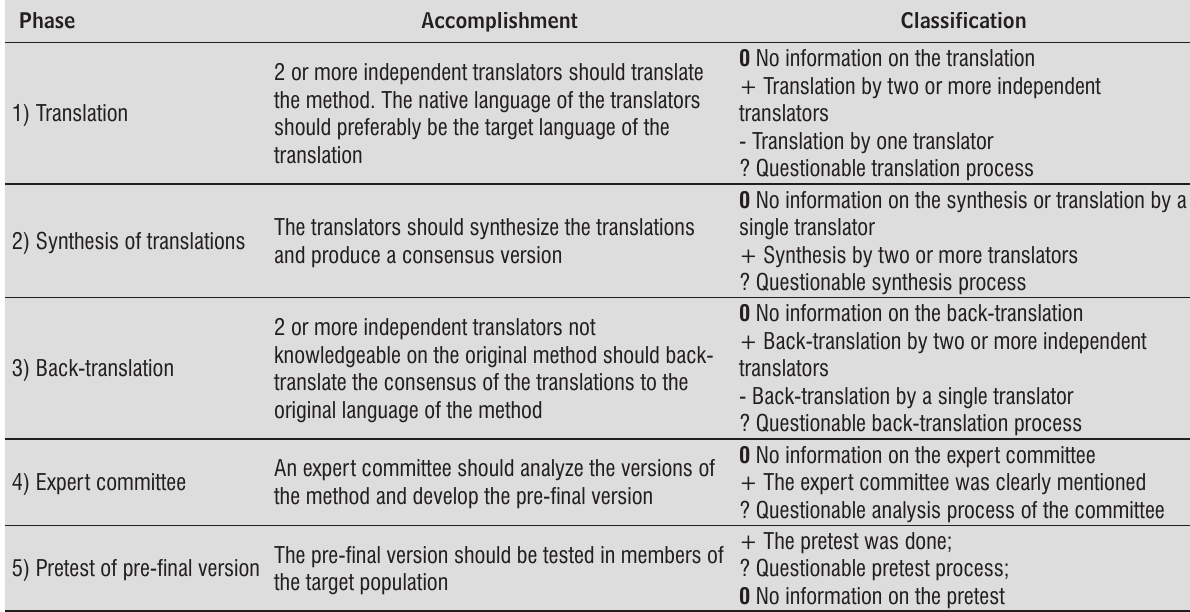
Table 1 - Guidelines for cross-cultural adaptation procedures of questionnaires (10, 12, 13)